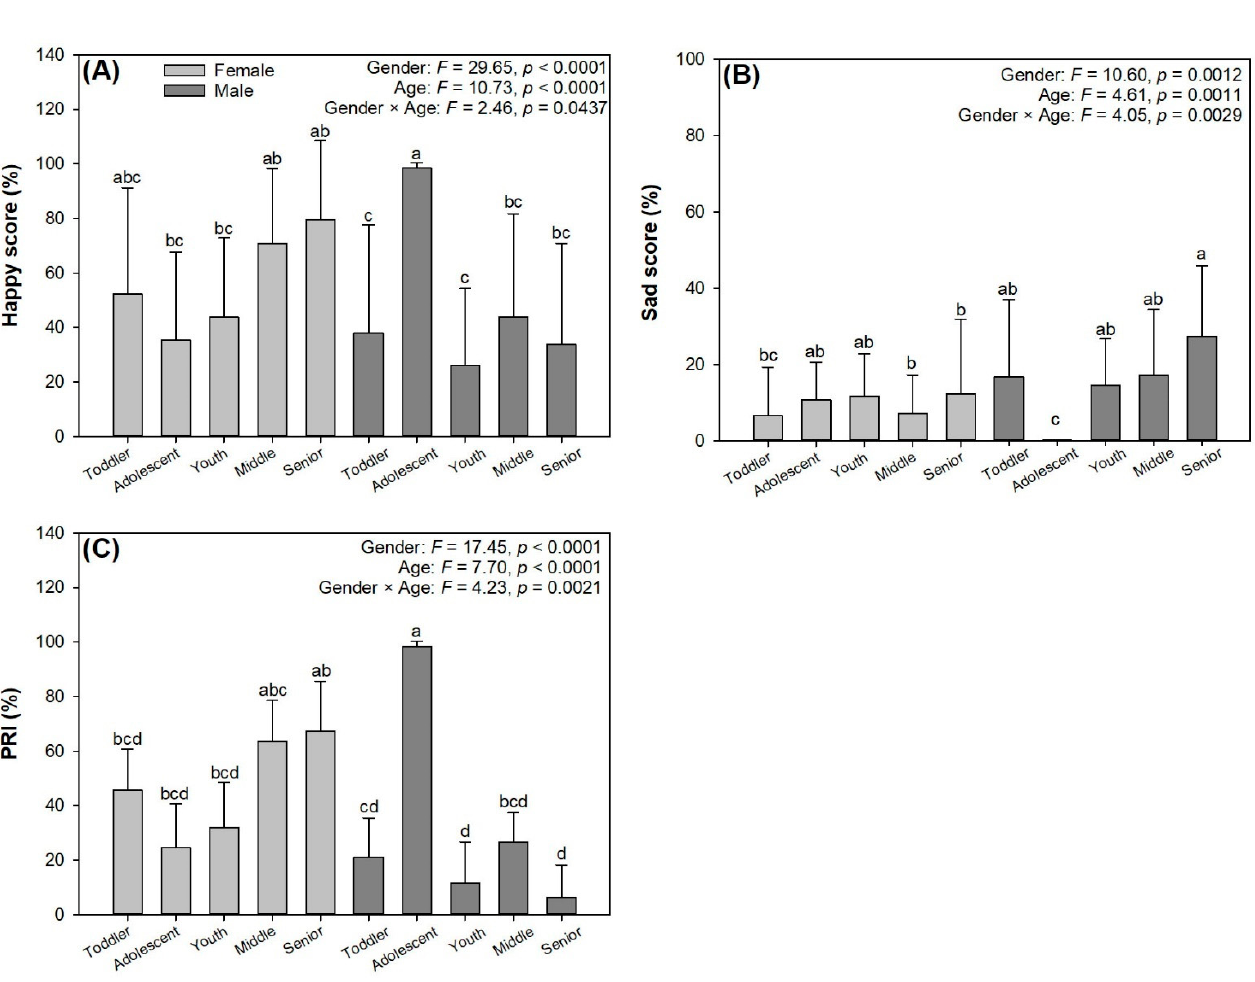
Figure 2. Differences of facial expression scores for happy ( A ) and sad emotions ( B ) and net positive emotion (positive response index, PRI) ( C ) for visitors in different genders and ages at parks in Northeast China. Analysis of variance (ANOVA) results on the interactive effects of gender and age on facial expression scores have been shown in each cell. Error bars present standard errors with different lower-case letters above as significant difference according to Duncan test at the significance of no higher than 0.05.